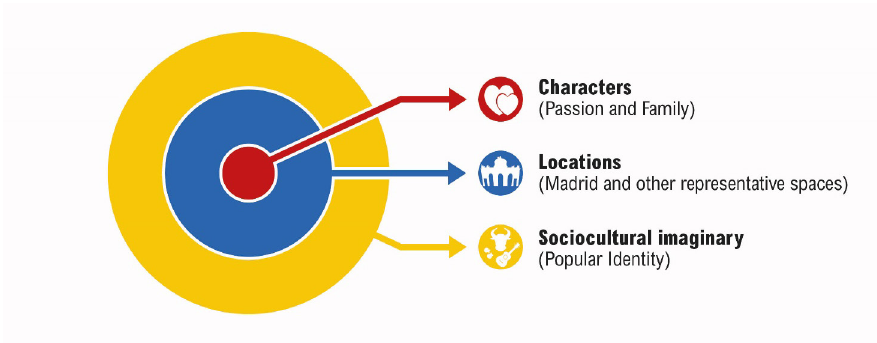
Figure 1. Research indicators (source: created by